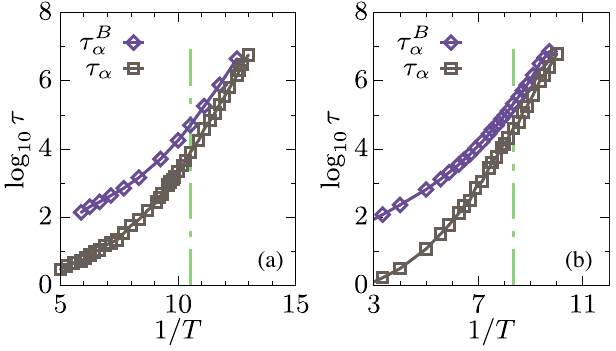
FIG. 20. Convergence of relaxation times at low temperature in 3D (a) and 2D (b). Relaxation times τ α defined from the self- t Þ (a) and bond-orientational intermediate scattering function F s ð correlation C Ψ ð t Þ (b) compared to the relaxation time τ B α defined t Þ . The very different from the bond-breaking correlation C B ð timescales measured at high temperatures become identical at low temperatures, much below T (dotted dashed MCT